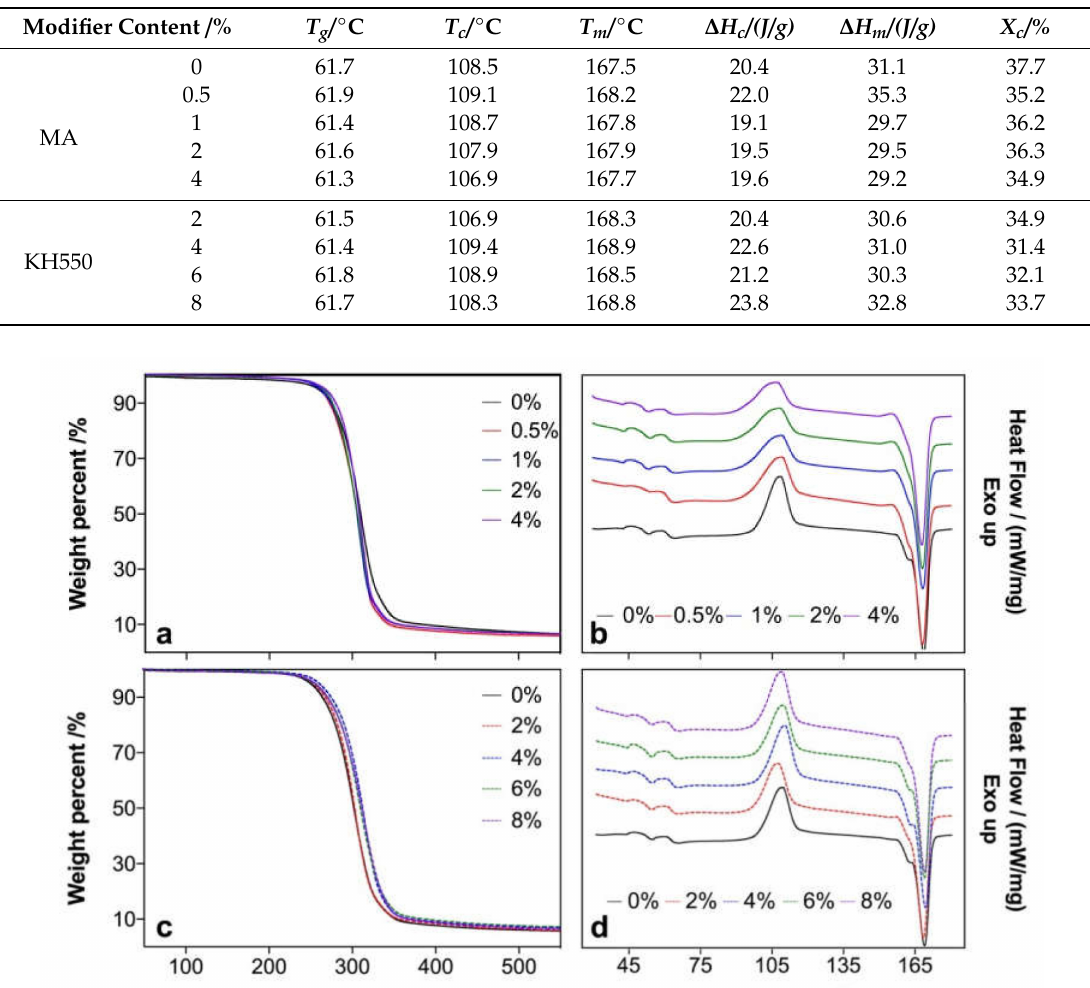
Table 2. Di ff erential scanning calorimeter (DSC) thermal performance of MA- and KH550-modified poplar powder / PLA composites.